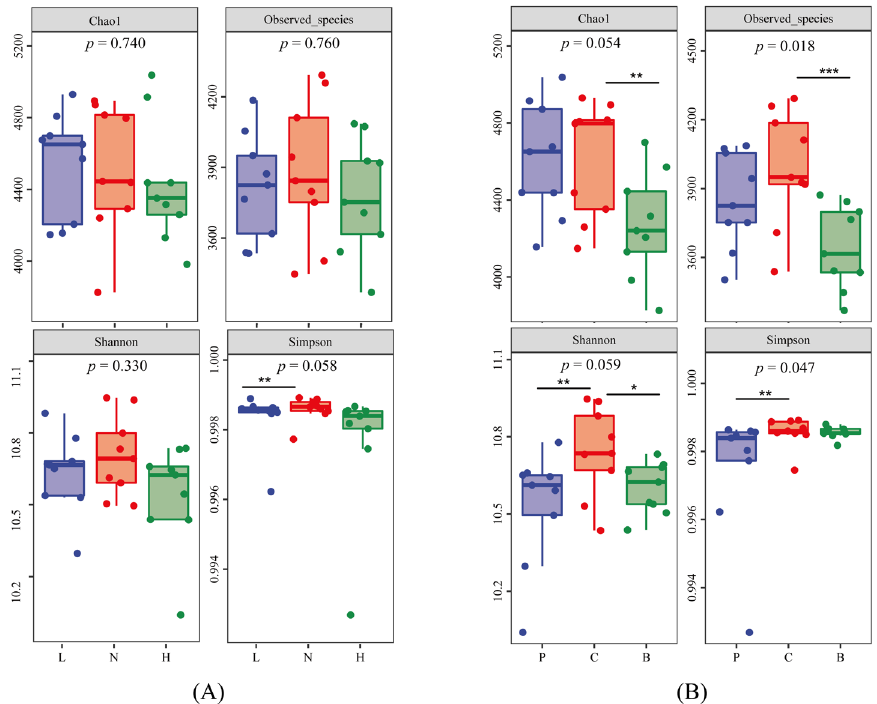
Figure 1. The α diversity of soil bacterial communities in the plots with different planting densities ( A ) and SRAs ( B ). p -values (* p < 0.1, ** p < 0.05, *** p < 0.01) were obtained from K–W tests. P, C, and B represent hydroxyapatite addition, no amendments, and biochar addition, respectively. L, N, and H represent low planting density, no planting, and high planting density, respectively.